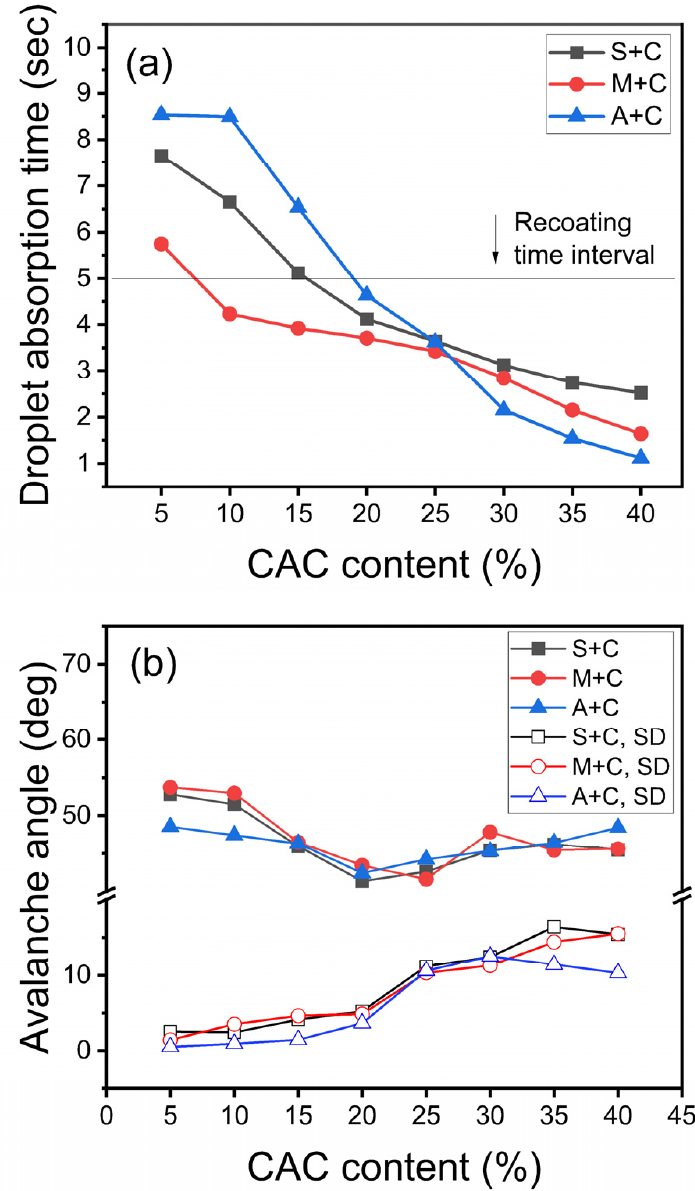
Figure 3. ( a ) Droplet absorption time and ( b ) avalanche angle by calcium aluminate cement (CAC) content.